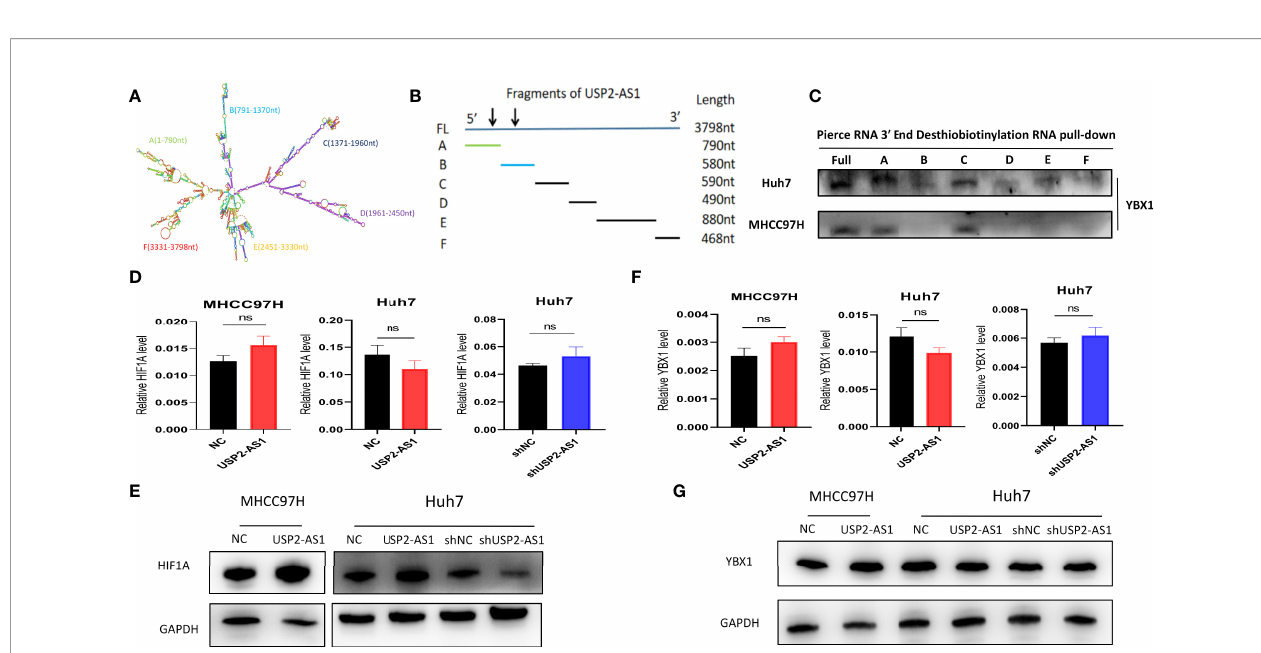
FIGURE 4 | USP2-AS1 increases HIF1 a translation under hypoxia. (A) The secondary structure of USP2-AS1 was predicted by RNAfold Webserver. (B) Six truncated probes ( A – F fragments) of USP2-AS1 were designed to perform RNA pulldown assays. (C) USP2-AS1 physically interacts with YBX1 by the A and C fragments under hypoxia measured by WB. (D) USP2-AS1 overexpression or knowdown failed to cause signi fi cant changes in HIF1 a mRNA measured by qRT-PCR. (E) USP2-AS1 affects HIF1 a protein levels, as measured by WB. (F) USP2-AS1 overexpression or knowdown failed to cause signi fi cant changes in YBX1 mRNA measured by qRT- PCR. (G) USP2-AS1 overexpression or knockdown does not affect YBX1 protein levels compared with the controls, ns means not signi fi